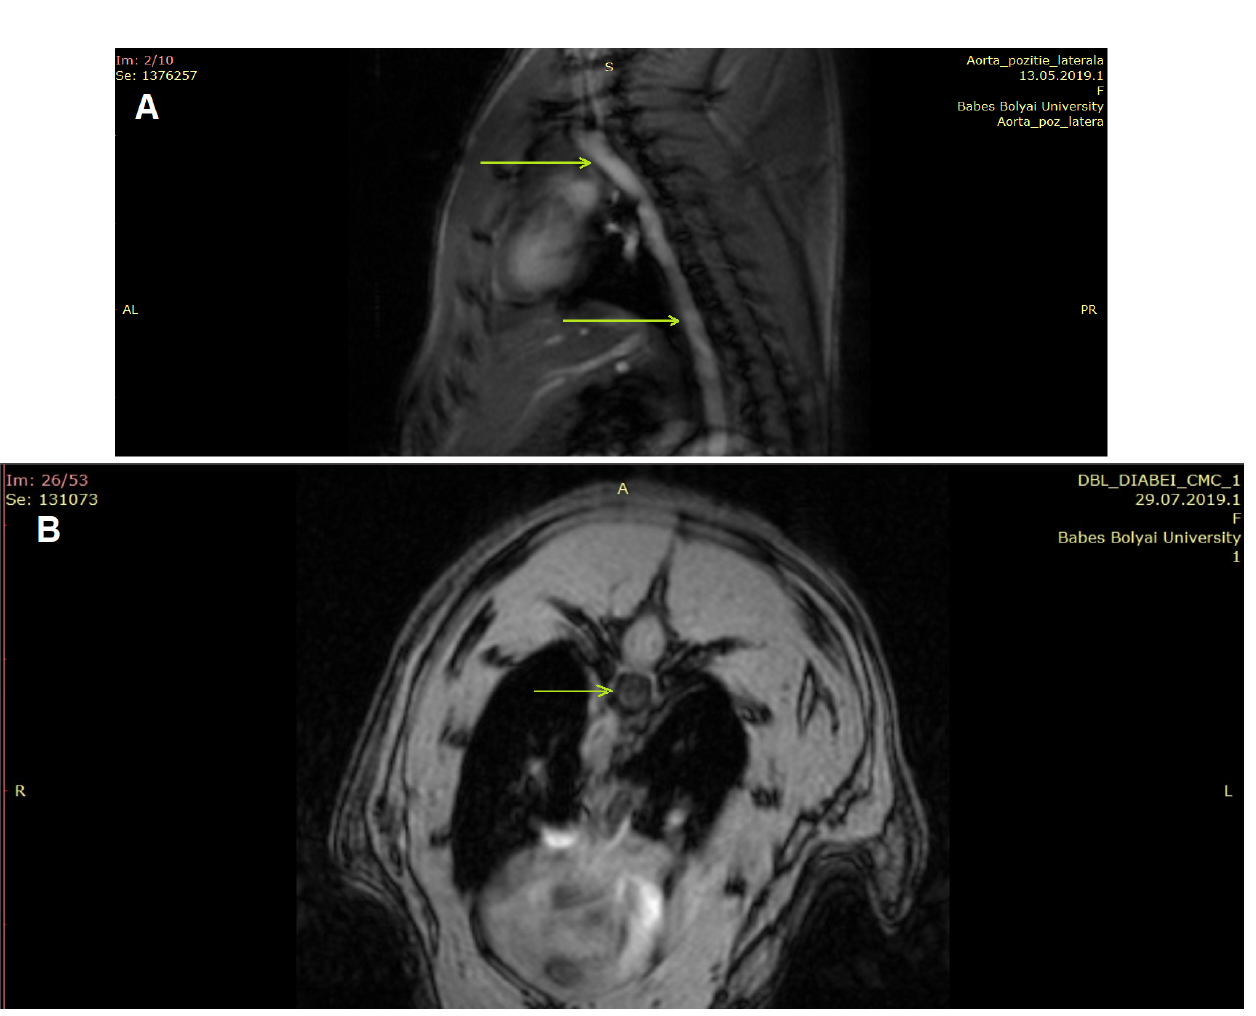
Figure 1. The investigated aorta segment (sagittal section) ( A ) and an example of the sections used for 3D reconstruction ( B ), using the IntraGateFlash CINE scanning technique.